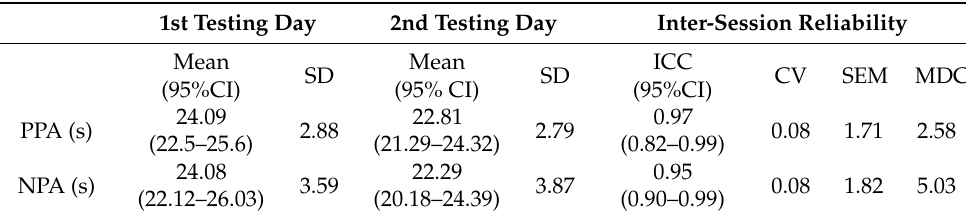
Table 1. Inter-testing reliability of the newly developed tests of the pre-planned agility and non- planned